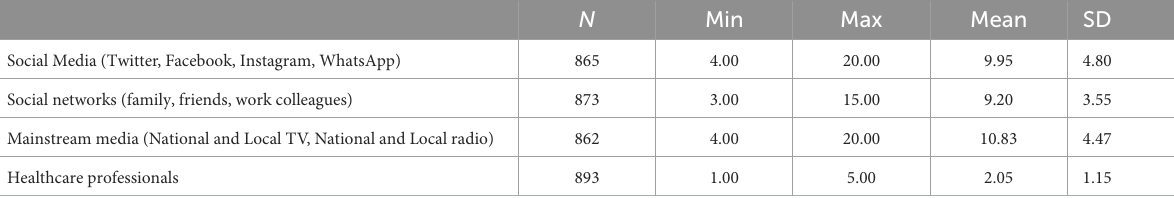
TABLE 3 Frequency of sources used (by category) by participants to access information about COVID-19. N Min Max Mean SD Social Media (Twitter, Facebook, Instagram, WhatsApp)